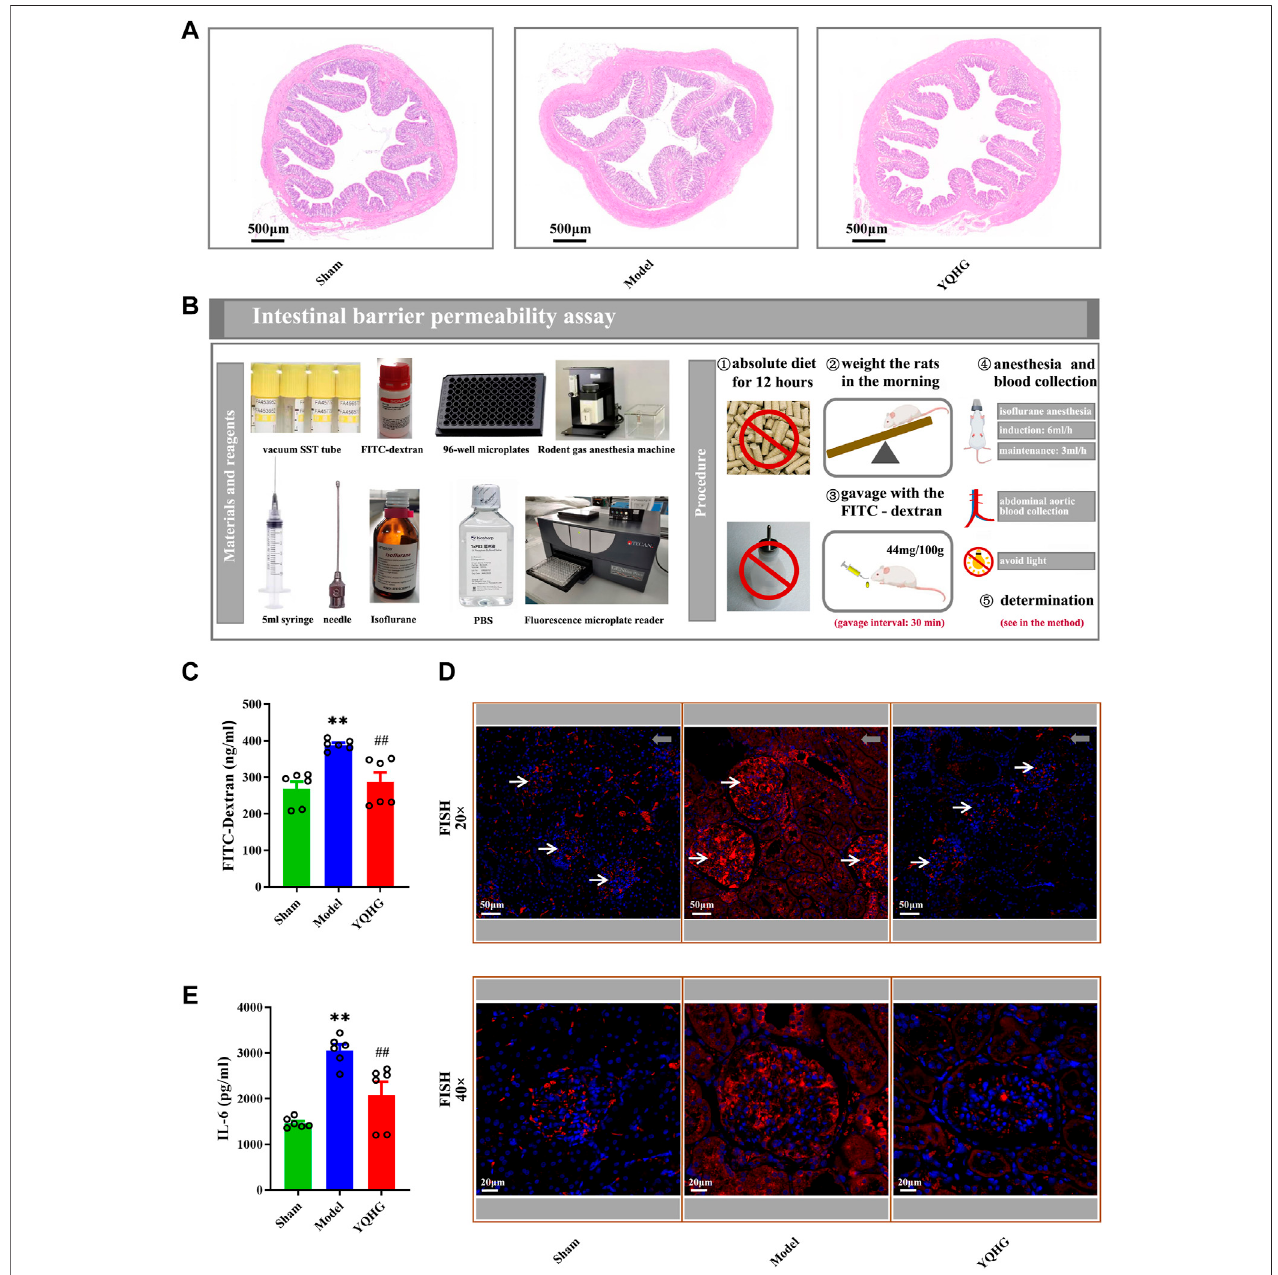
FIGURE 5 | YQHG improves intestinal barrier integrity in 5/6 nephrectomized rats. (A) Representative images of H&E (2.0 × Magni fi cation, Scale bar 500 μ m) stainingof colontissues. (B) Details ofthe gut barrier permeability assay. (C) The concentrationof FITC-dextran in serum was determined. (D) Representative images of FISH analysis (20 × Magni fi cation, Scale bar 50 μ m; 40 × Magni fi cation, Scale bar 20 μ m) in renal tissues. The red and blue fl uorescent signals represent the probe and the nucleus, respectively. White arrows represent glomerulus, and gray arrows represent tubulointerstitium (20 × Magni fi cation, Scale bar 50 μ m). (E) The expression of IL-6 in renal tissues was determined. All data are expressed as means ± SEM. For non-normally distributed data (FITC-Dextran, IL-6), Kruskal-Wallis test followed by non-parametric Wilcoxon rank-sum test was used. ** p < 0.01 vs. the sham group; ## p < 0.01 vs. the model group.